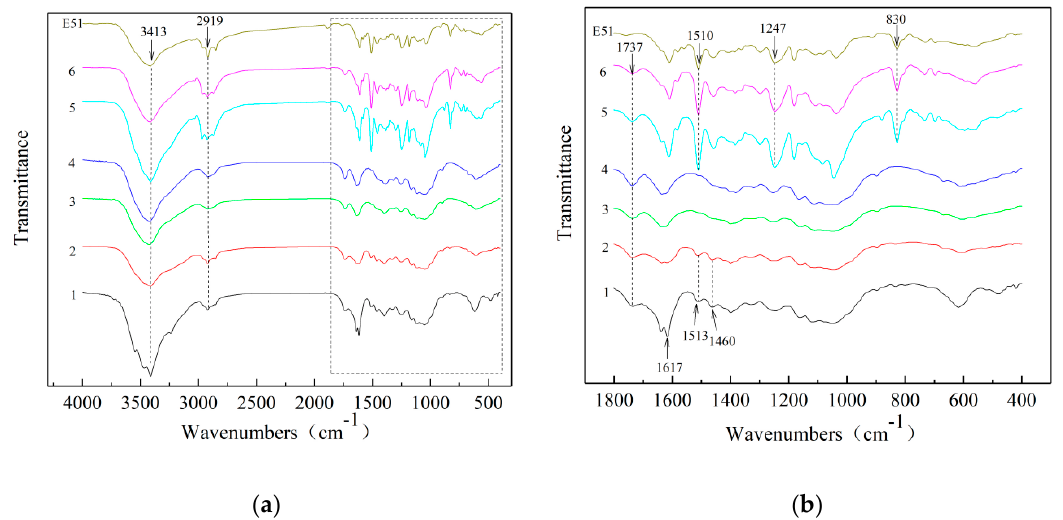
Figure 2. Fourier transform infrared (FTIR) curves of inner bamboo (IB) and heat-treated inner bamboo (HIB) before and after delignification and vacuum impregnation (( b ) is an enlarged view of the dotted box part of ( a ). (1) IB; (2) HIB; (3) DIB; (4) DHIB; (5) TIB; (6) THIB.